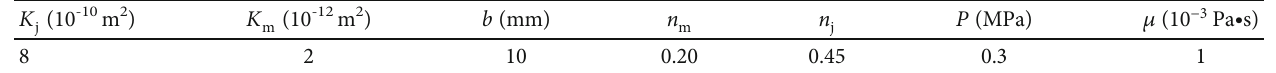
Figure 9: Finite element model using COMSOL multiphysics. Table 1: Microparameters of the numerical model in the simulation.